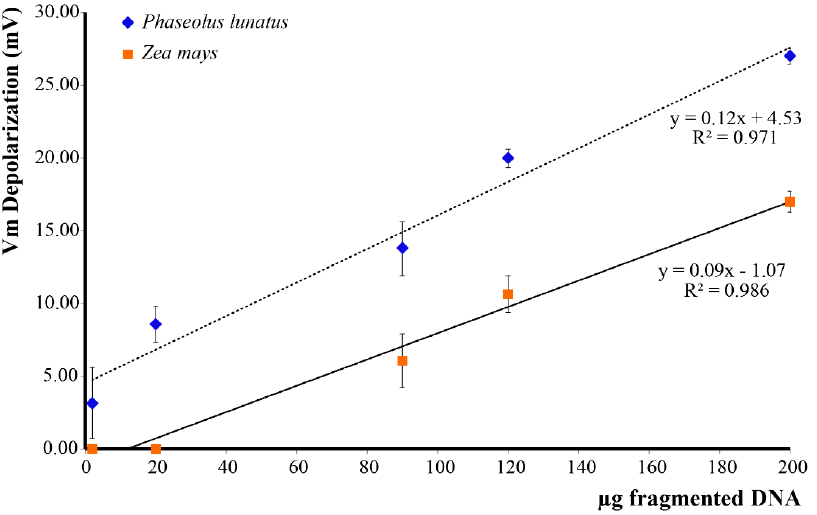
Figure 2. Plasma membrane potential (Vm) depolarization caused by increasing concentrations of extracellular self-DNA (esDNA) in Lima bean and maize. Error bars represent standard error ( n = 8–10). Regression equation and the coefficient of determination are indicated for each species.